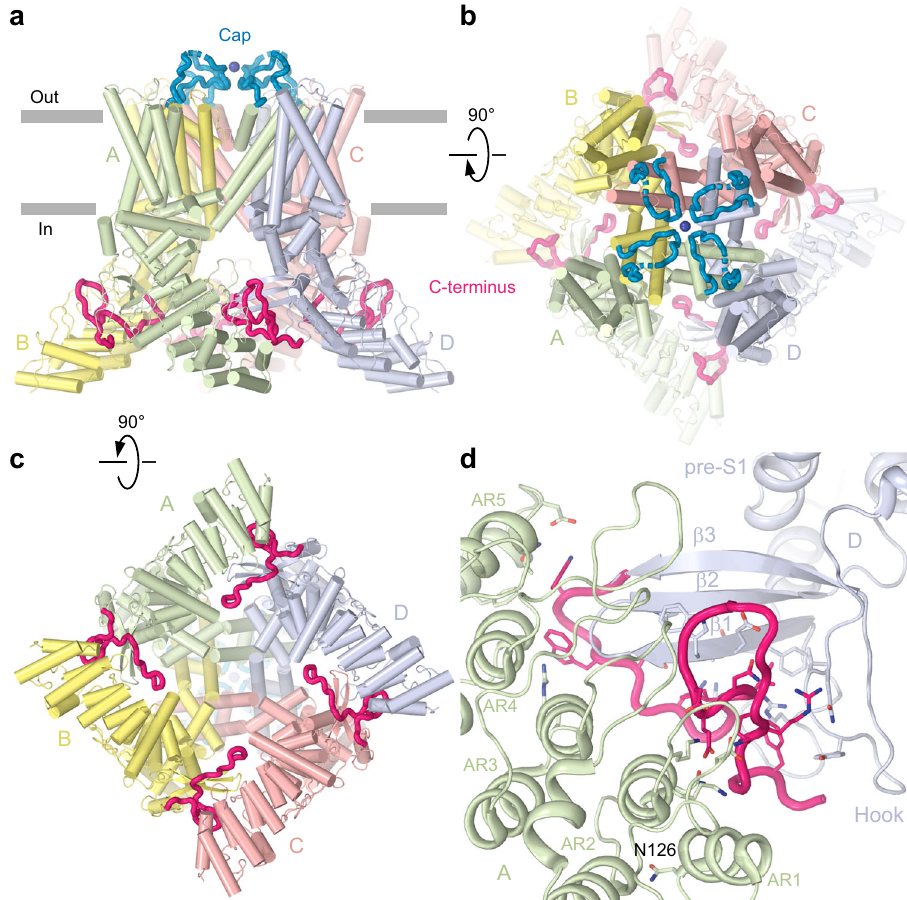
Fig. 1 Structure of full-length sqTRPV1. a – c Side ( a ), top ( b ) and bottom ( c ) views of full-length sqTRPV1 structure with four subunits coloured differently, the cap domain in blue and the C-terminus in pink. Dark blue sphere is a putative chloride ion. d Close-up view of the C-terminus with the residues contributing to interactions with other domains shown in sticks. Asparagine N126, the serine substitution of which converts weakly temperature-sensitive sqTRPV1 into highly temperature-sensitive rTRPV1-like channel, is